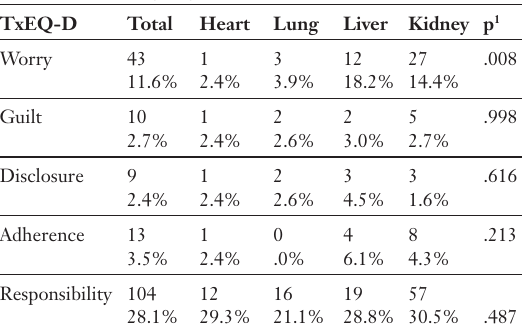
Table 3 Absolute and relative frequencies of pa- tients who assert (= 1) or deny (= 0) that they worry about the transplant ( >